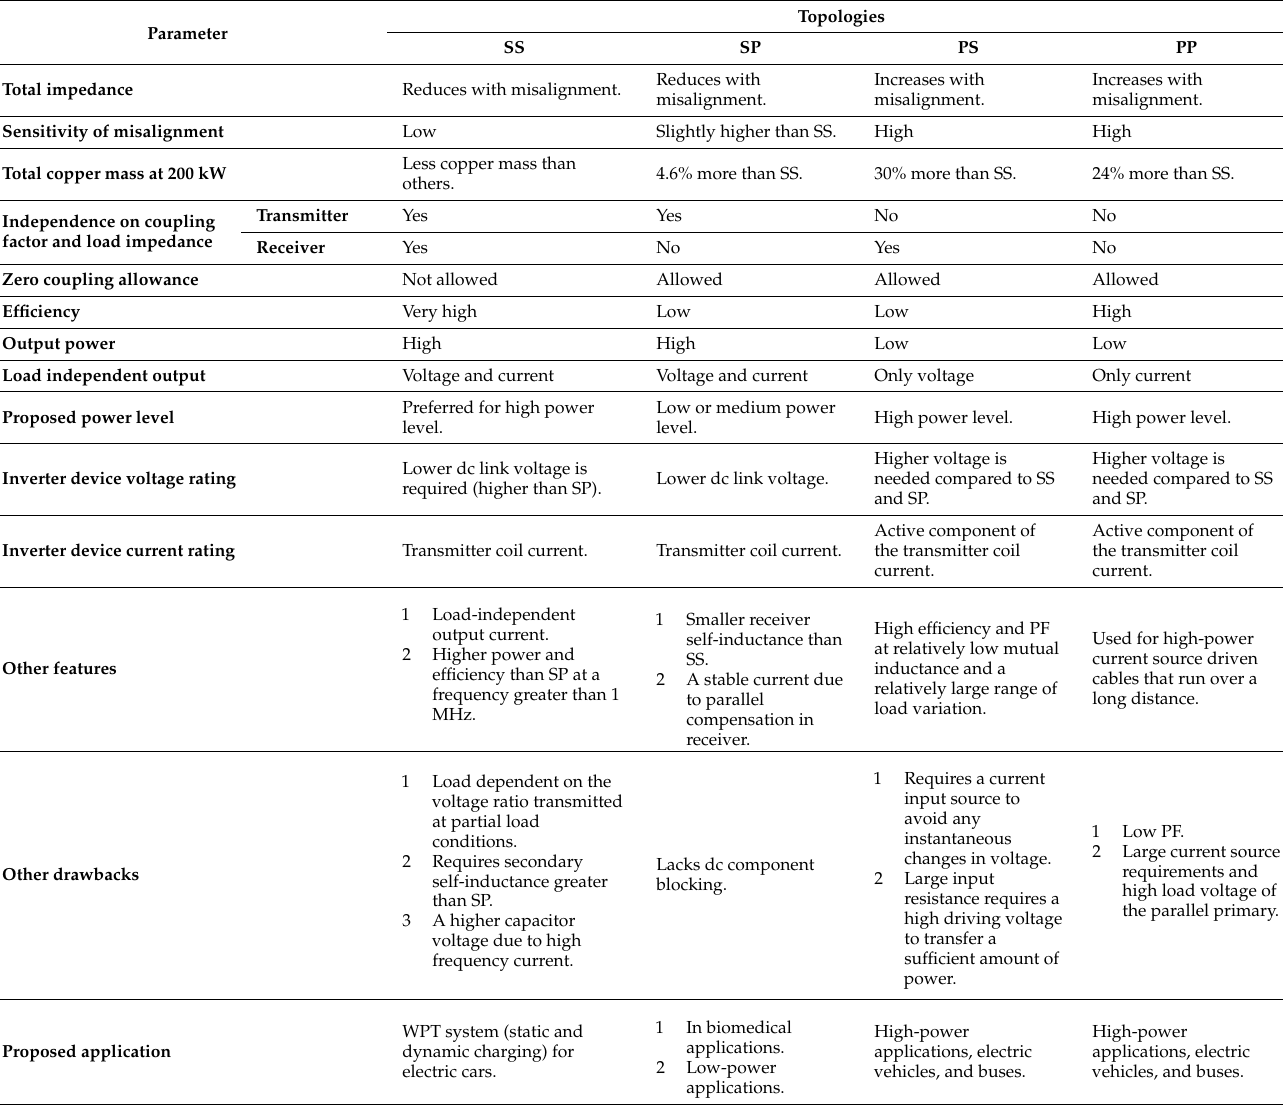
Table 4. Comparison of four basic topologies